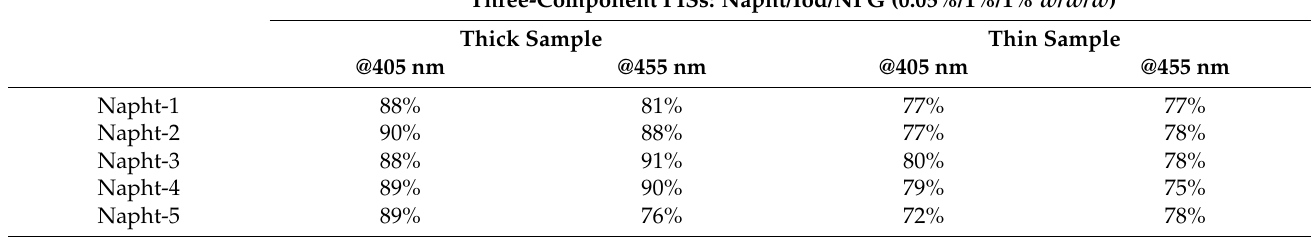
Table 3. Final reactive function conversions (FC%) for TA using three-component PISs upon visible light irradiation using the LEDs @405 nm and 455